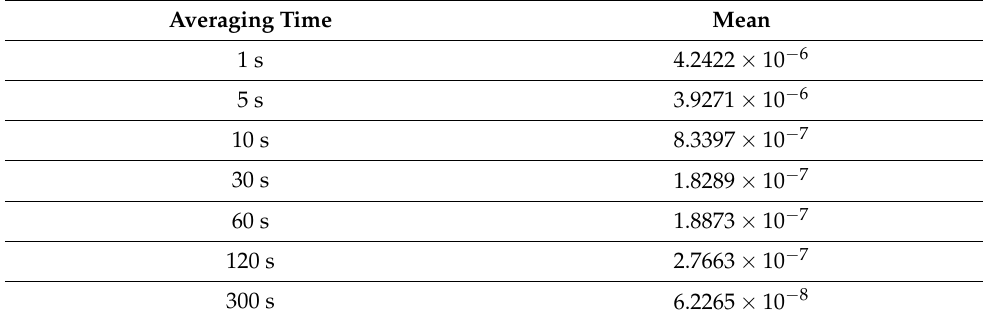
Table 3. Mean values of the MDEV changes of the CubeSats’ clocks when the numbers of stochastic accelerations are doubled compared to the default settings for the CubeSats observations with a high rate of outliers (>50%).